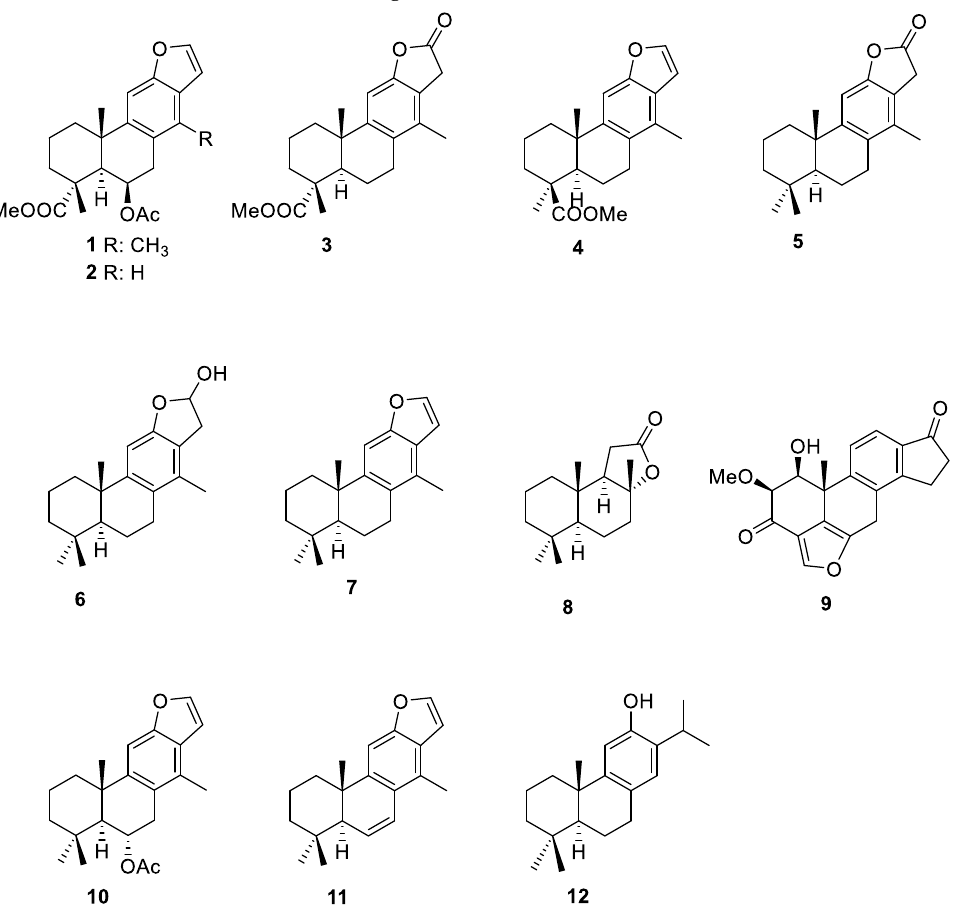
Figure 1. Some aromatic cassane-type terpenes and viridin derivatives.